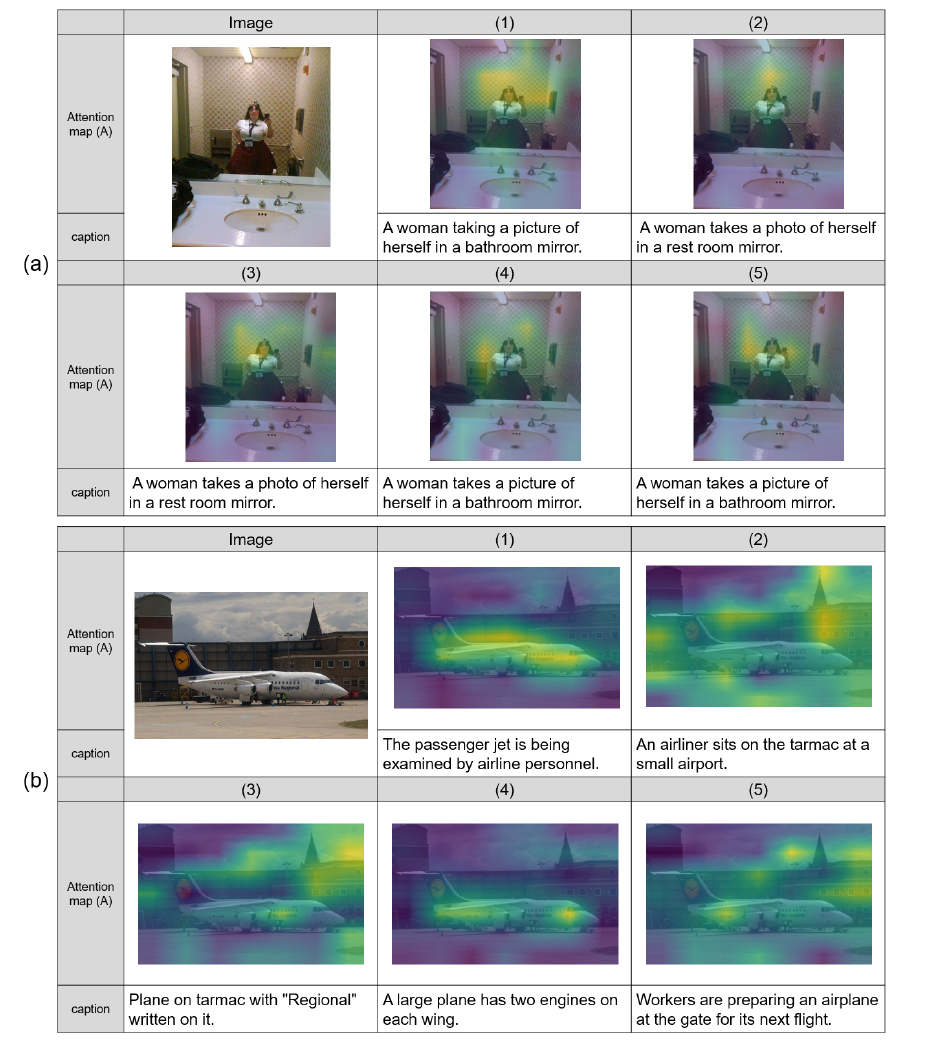
Figure 2. Examples of a generated CAM derived from each caption for an image. ( a ) with low diversity (Div-1 = 0.321) and ( b ) with relatively high diversity (Div-1 = 0.791). The highlighted parts of five CAMs are more diverse in ( b ) than in ( a